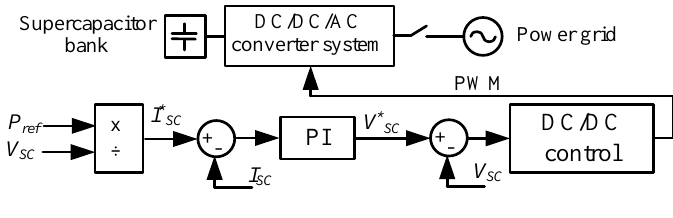
Figure 9. SCESS Figure 9. SCESS configuration.